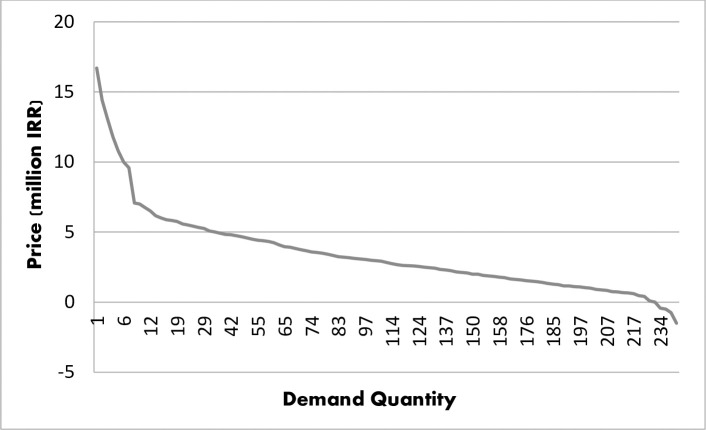
IVF demand curve.